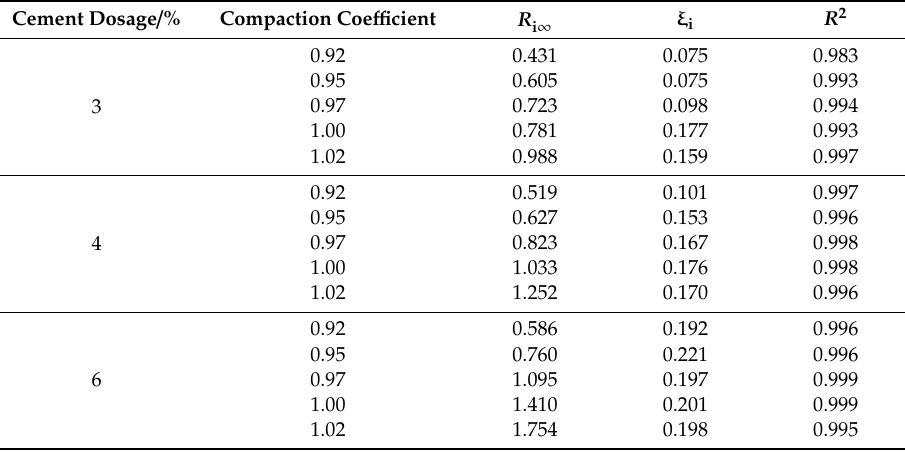
Table 5. Estimation equation for unconfined splitting strength of cement-improved loess. Cement Dosage /